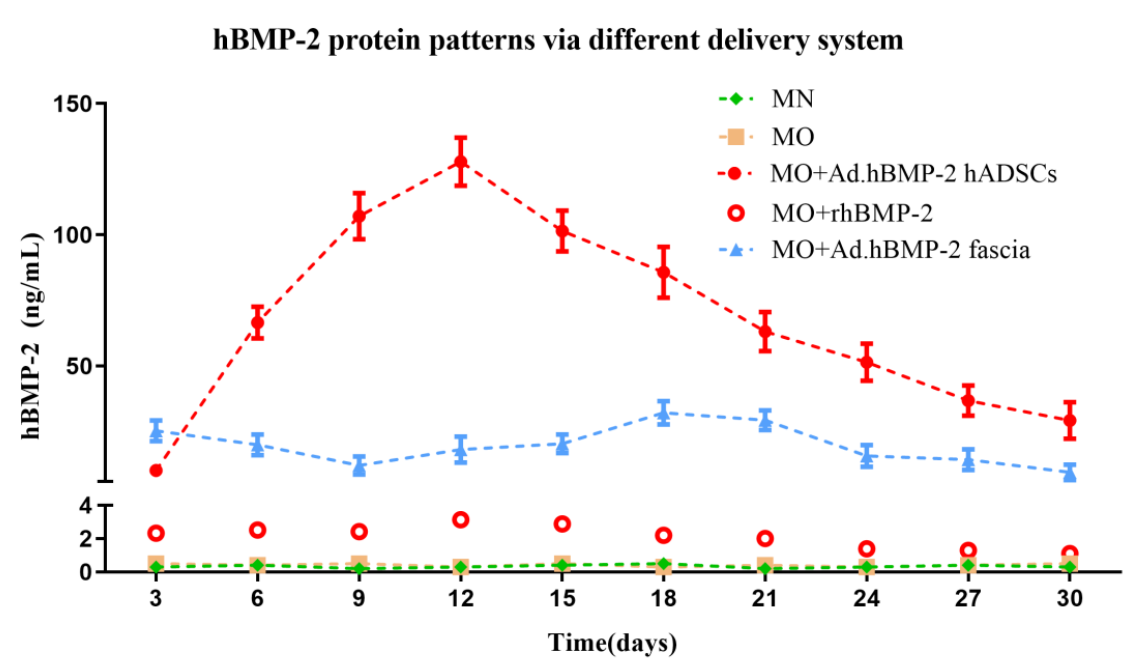
Figure 4. Human BMP-2 protein level patterns via different hBMP-2 delivery systems measured in supernatants harvested every 3 days until day 30. Human BMP-2 was continuously released from group MO + Ad.hBMP-2 hADSC and group MO + Ad.hBMP-2 fascia. In the MO + rhBMP-2 group, the same amounts of recombinant proteins as those produced by the MO + Ad.hBMP-2 hADSC group were added, and degraded significantly to a minimal level (around 2 ng/mL) after 3 days in culture at each time point (red circle dot, without connected line). Little to no hBMP-2 was detected in non-transduced groups: MN and MO.